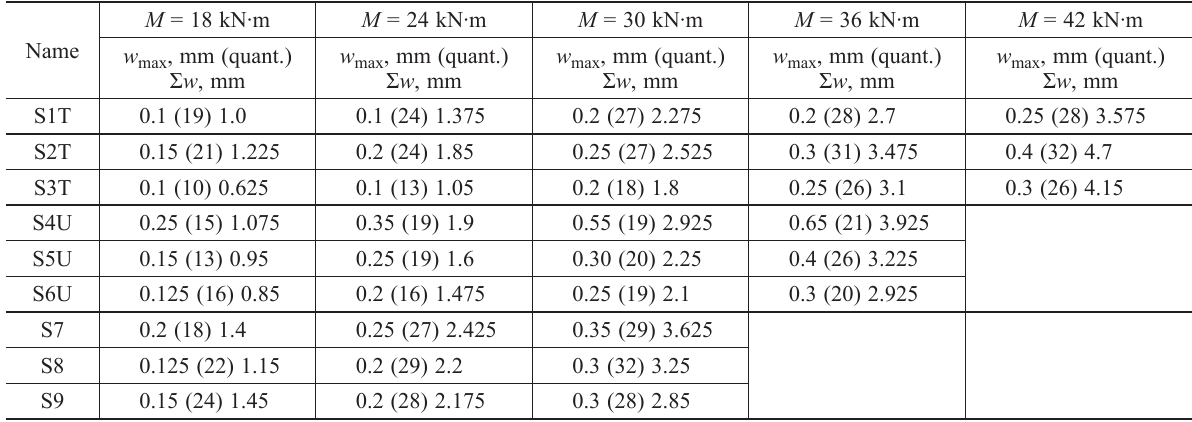
Table 11. Parameters of the cracks: maximal width, quantity, sum of the cracks width